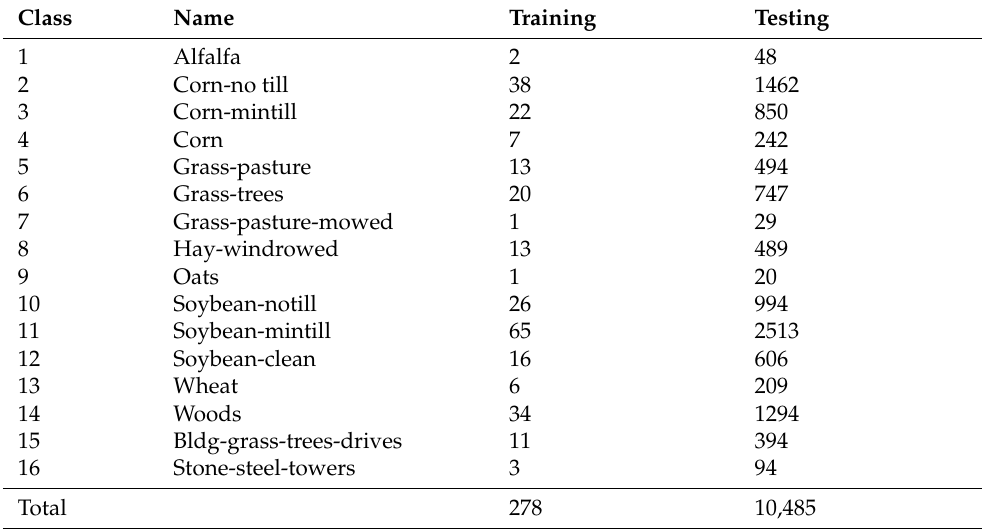
Table 1. Class-based numbers of training and testing samples for Indian Pines.